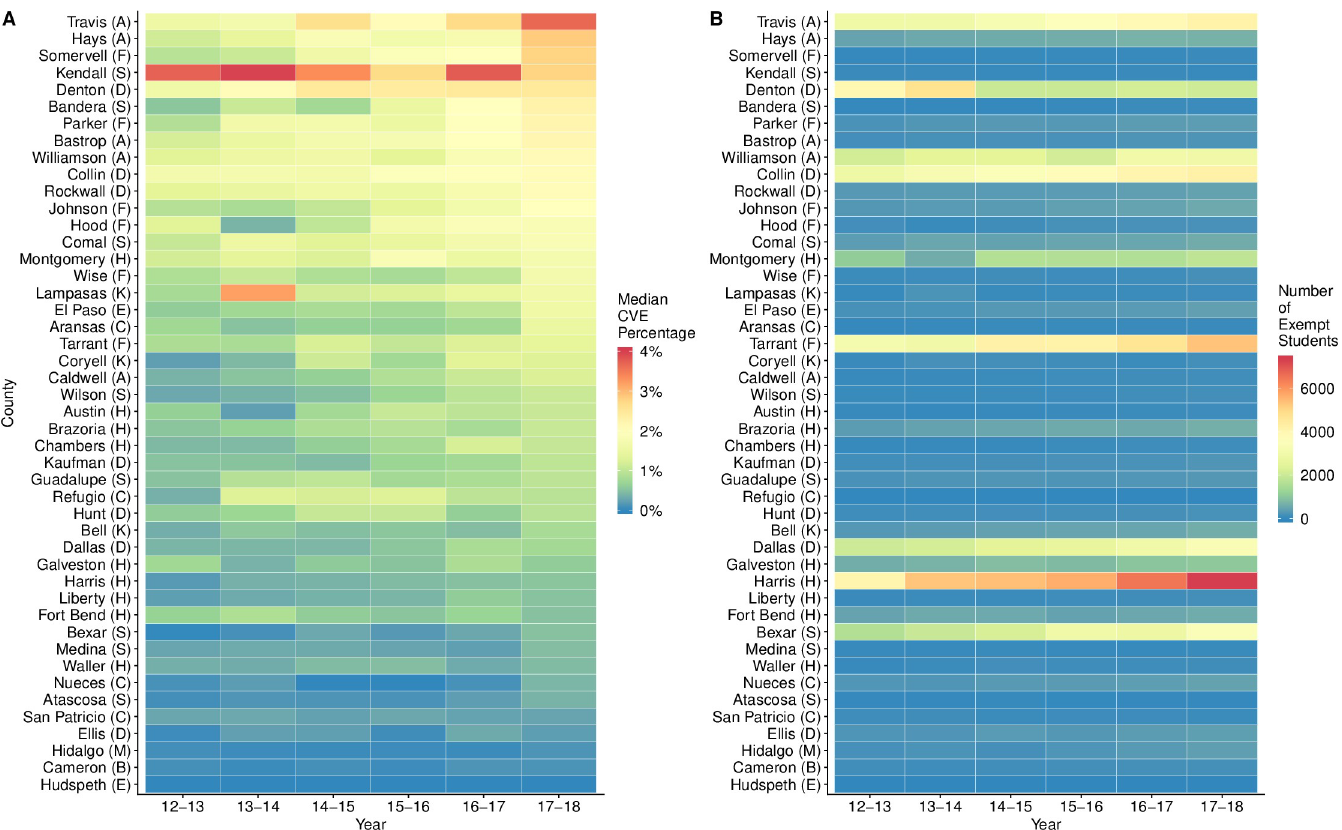
Fig 1. CVE trends in counties within ten major metropolitan areas of Texas. A: The median CVE percentages across all public, private, and charter school systems in each county and year. B: The estimated number of vaccination-exempt students in each county and year. For each county, we summed the product of each school system’s annual CVE percentage and its 2016 enrollment. In both graphs, counties are ordered according to their 2017–2018 median CVE percentage. The metropolitan areas are indicated by the following: Houston (H), Dallas (D), Fort Worth (F), San Antonio (S), Austin (A), McAllen (M), El Paso (E), Corpus Christi (C), Brownsville (B), and Killeen (K). The values for 2017–2018 are also depicted on a map of Texas counties (Fig B in S1 Appendix). CVE, conscientious vaccination